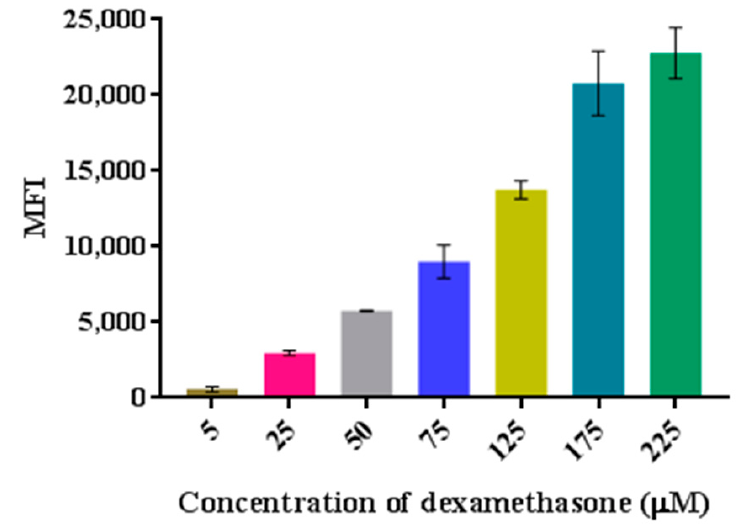
Figure 7. Flow cytometric profile of ARPE-19 cells incubated with pullulan-dexamethasone-cyanine3 at increasing concentration. Concentration is referred to conjugated dexamethasone. MFI: Mean Fluorescence Intensity.